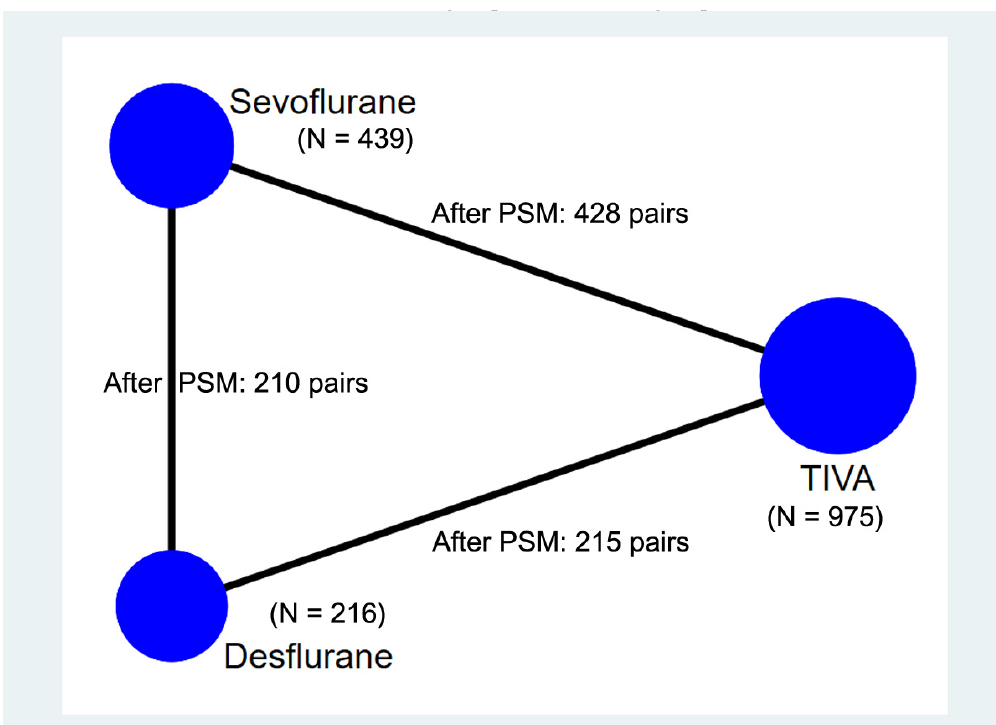
Figure 1. Network plot denoting the study group and number of patients in groups and propensity score matching. PSM = propensity score matching.